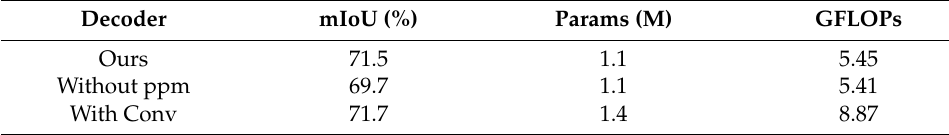
Table 6. Ablation study of modules in the decoder on Cityscapes.